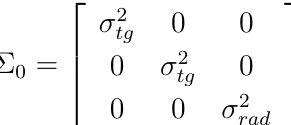
, s [1] and s [2] . The camera system is located at the origin. t t t and σ for the radial and tangential direction. The iso-lines show rad tg